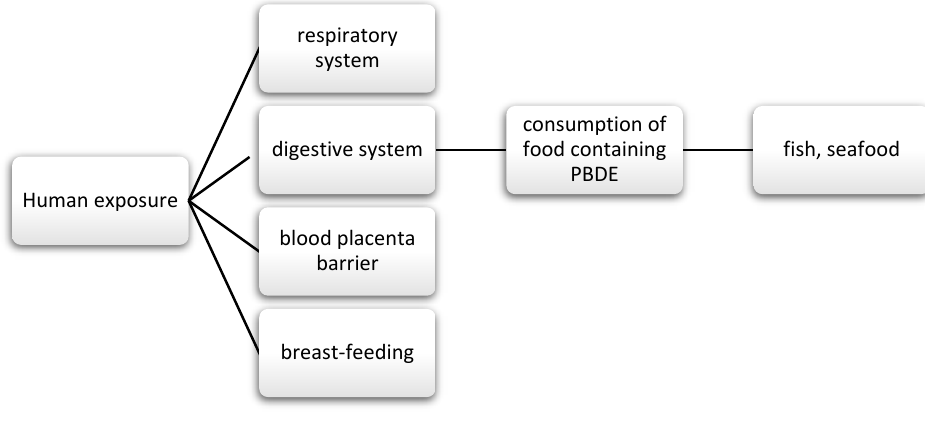
Figure 6. Main routes of exposure to